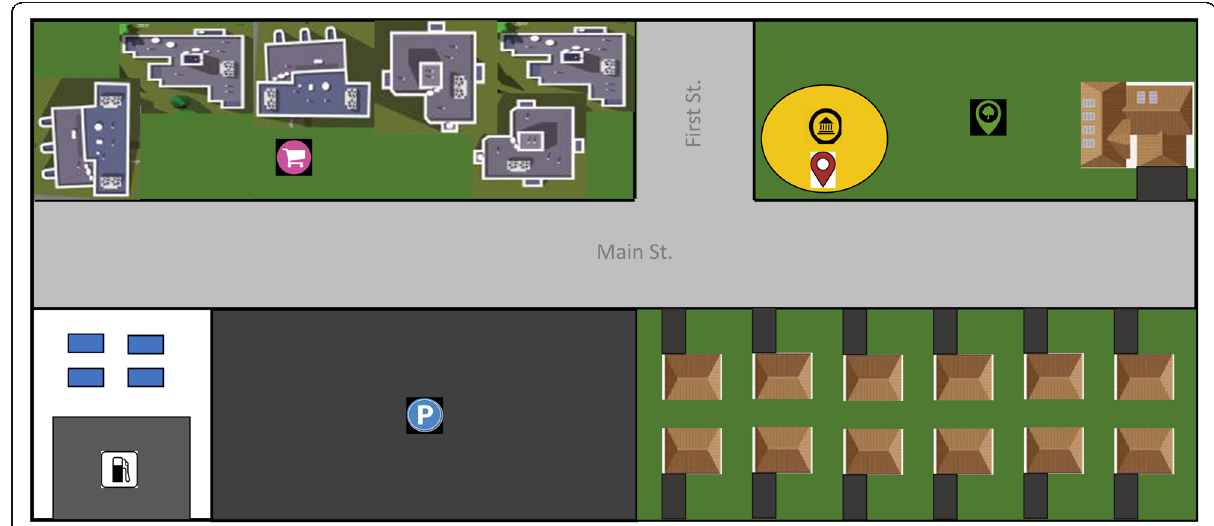
Fig. 1 Example community map. Imagine standing at the bank ( yellow oval ) and needing to find a grocery store. Landmark information differs in the visual character of different buildings or other spaces. Here landmark information could be the parking lot, a house, or the shopping center. Landmark configuration can be seen in the relative density or layout of landmarks. A useful landmark configuration here could be a housing development next to a parking lot which is across the street from a business center. A grocery store is less likely to be in a housing development than a shopping center, and a parking lot is indicative of a lot of traffic (which could be near a shopping center). Geometric information relates to the shape or layout of the entire environment and here can be examined globally as the grid-like layout of the streets on this map or locally with the rectangular layout of the business center. Although the figure gives only a snapshot of the community, its rectangular form reflects the overall environment